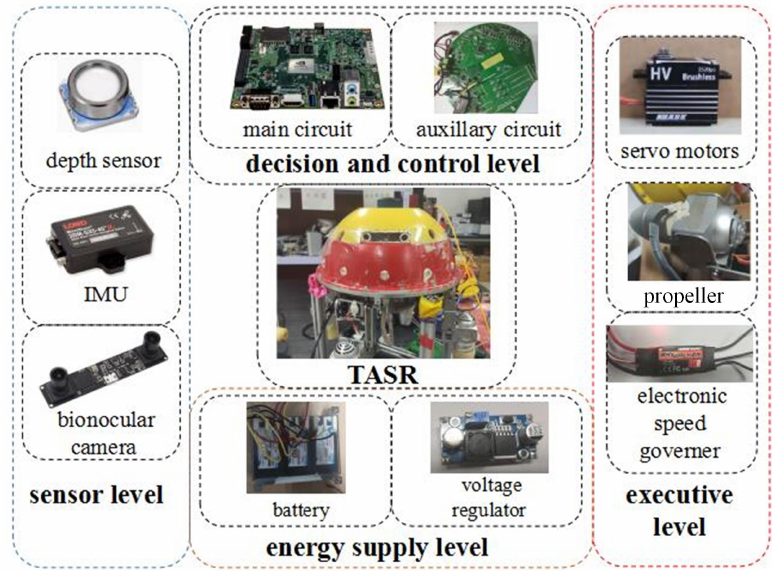
Figure 3. The TASR’s circuit system components.